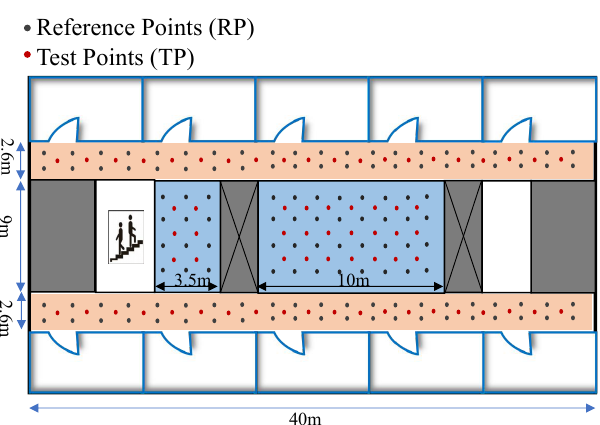
Figure 5. Experimental